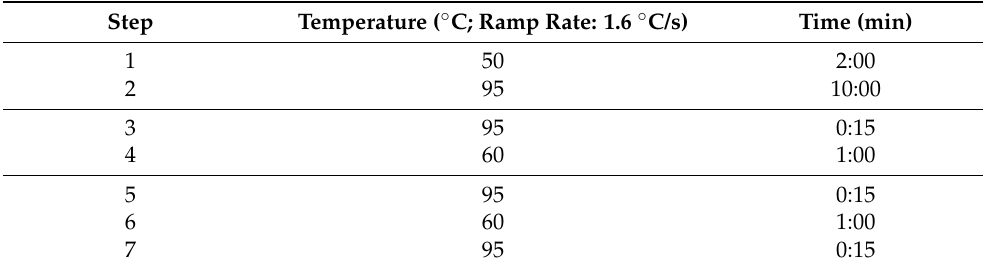
Table 2. Thermocycling conditions for RT-qPCR. Step 3 and 4 were repeated for 40